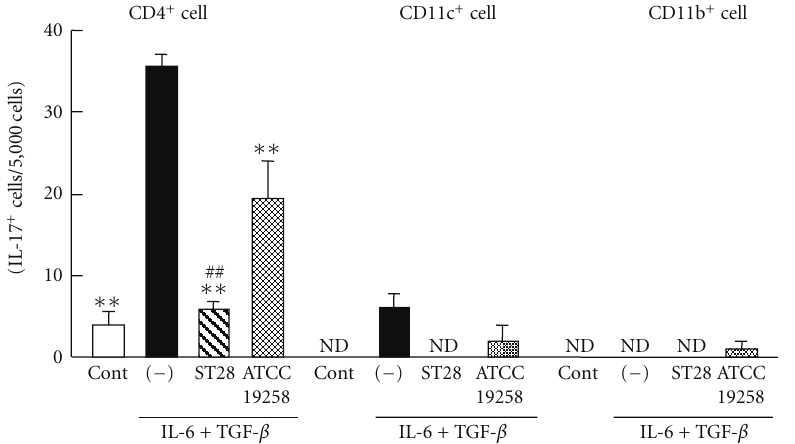
Figure 1: The suppressive e ff ect of S. thermophilus ST28 on Th17 cells in murine splenocytes. Splenocytes were stimulated with TGF- β plus IL-6 in the absence ( − ) or presence of ST28 and applied to flow cytometry. The number of CD4 + , CD11b + , and CD11c + cells in 5,000 IL-17 + cells is indicated. Splenocytes without the stimulation of TGF- β plus IL-6 were used as controls (Cont). ## P < 0 . 01 ( S. thermophilus ST28 versus S. thermophilus ATCC 19258). ∗∗ P < 0 . 01 (( − ) versus Cont, S. thermophilus ST28, or S. thermophilus ATCC 19258). ND, not